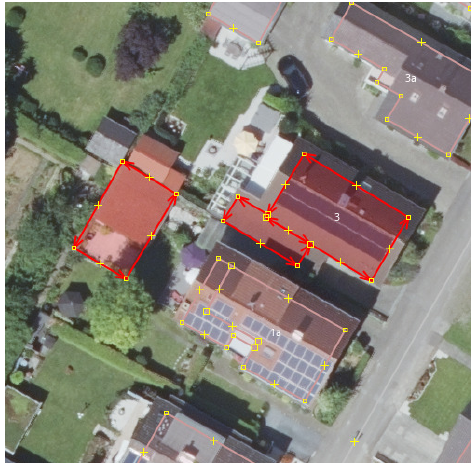
Figure 3. Building footprints obtained through Open Street Maps are sometimes misaligned or missing. The highlighted footprint on the left for example overlaps with some pavement and lawn. The one on the right is too narrow.